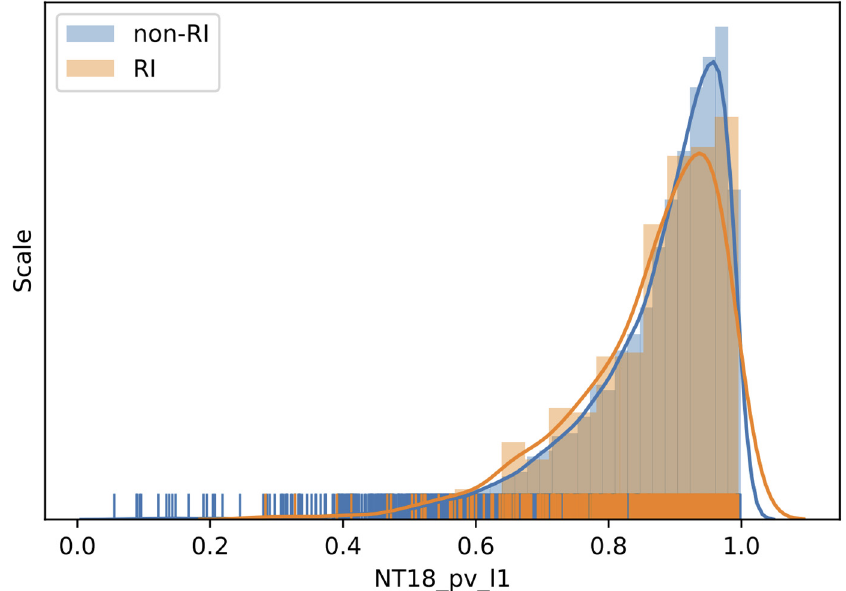
Figure 3. Same as Figure 2 but for variable NT18_pv_l1 (potential vorticity 18 h before current time at 1000 hPa).